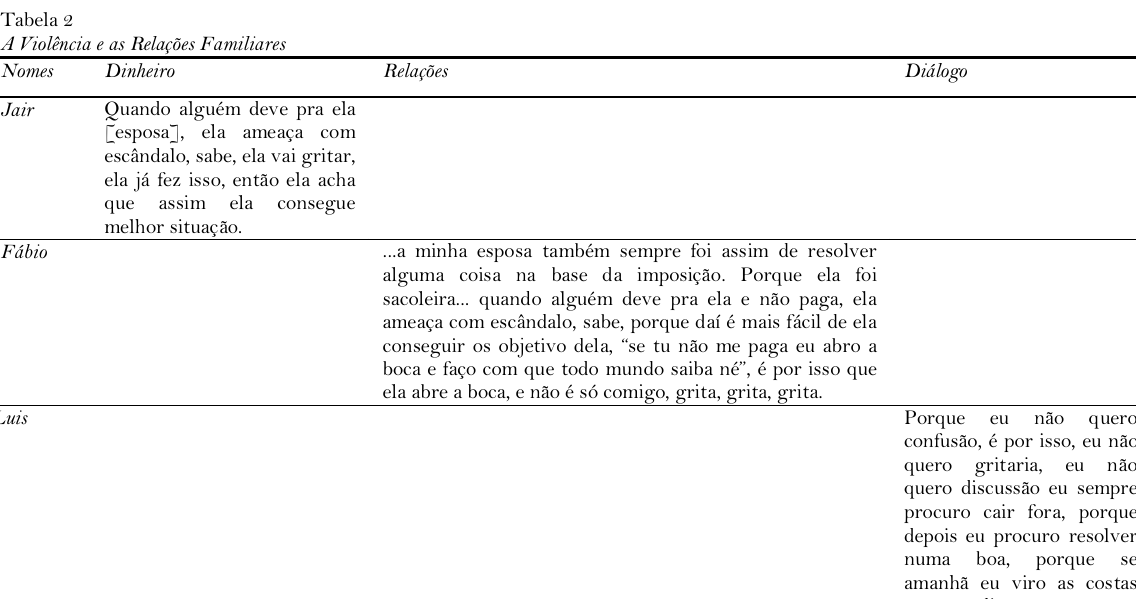
Tabela 2 A Violência e as Relações